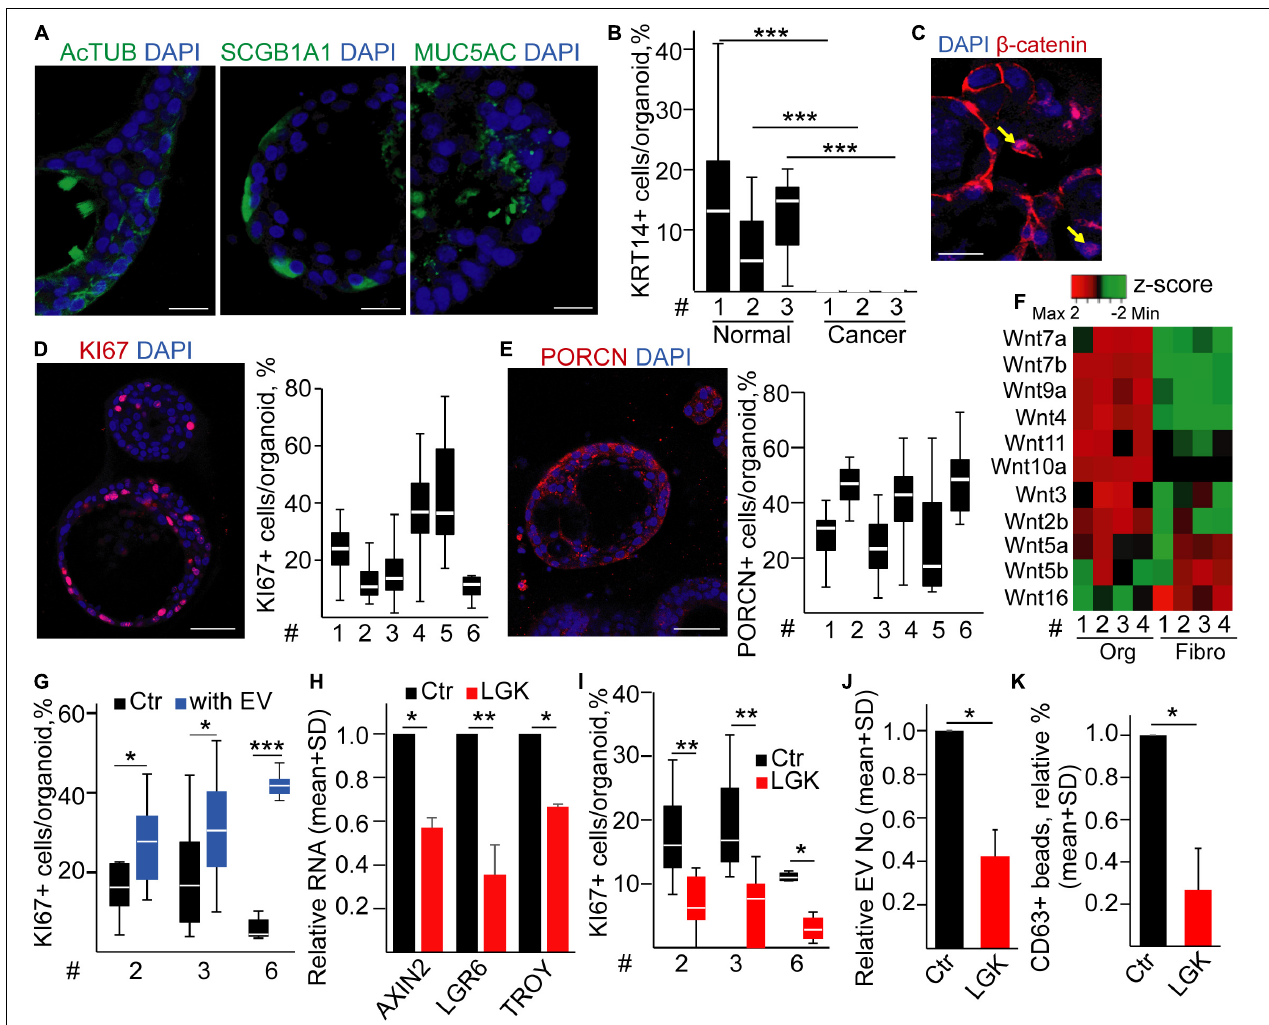
FIGURE 5 | Modulating the proliferative microniche in human lung adenocarcinoma (LUAD) organoids leads to a reduced EV release. (A) Detection of AcTUB, SCGB1A1, and MUC5AC in LUAD organoids (immunostaining and confocal microscopic images). (B) The percentage of KRT14+ cells in three matched sample pairs representing bronchiolar and LUAD organoids (immunostaining and confocal microscopic analysis, 10 images/sample). (C) Confocal microscopic image for β -catenin. The arrows indicate nuclear localization. (D,E) Representative images and their quantification for KI67 (D) and PORCN (E) from different patient-derived LUAD organoids. (F) Expression profile of selected Wnt genes in LUAD organoids and fibroblasts (RT-qPCR, matched samples were used). Results normalized to HPRT1 housekeeping were z -score transformed. Red and green color codes indicate higher and lower RNA levels, respectively. (G) The ratio of KI67+ proliferating LUAD organoid cells in the absence (Ctr) and presence of LUAD fibroblast-derived EVs for 4 days (with EV). Confocal microscopic images were evaluated. (H) Relative RNA for the indicated genes after LGK974 treatment, compared to the untreated controls (Ctr) (RT-qPCR, n = 3). (I) The percentage of proliferating cells in the organoids in the presence or absence of LGK974 (quantification of confocal microscopic images). (J) EV number changes after adding the PORCN inhibitor (LGK), measured with NTA ( n = 4). (K) Changes in the percentage of anti-CD63-coated beads, incubated in media from control or LGK974-treated LUAD organoids. Data were normalized to 10 6 cells before determining fold changes (flow cytometry, n = 4). For panels (D,E,I) , 14–16 images from two experiments were collected for each organoid line. Mann–Whitney U -test (B,G,I) and one-sample t -test (H,J,K) were applied with * p < 0.05, ** p < 0.01, and *** p < 0.005. Scale bars: 20 µ m (A,C) or 50 µ m (D,E)